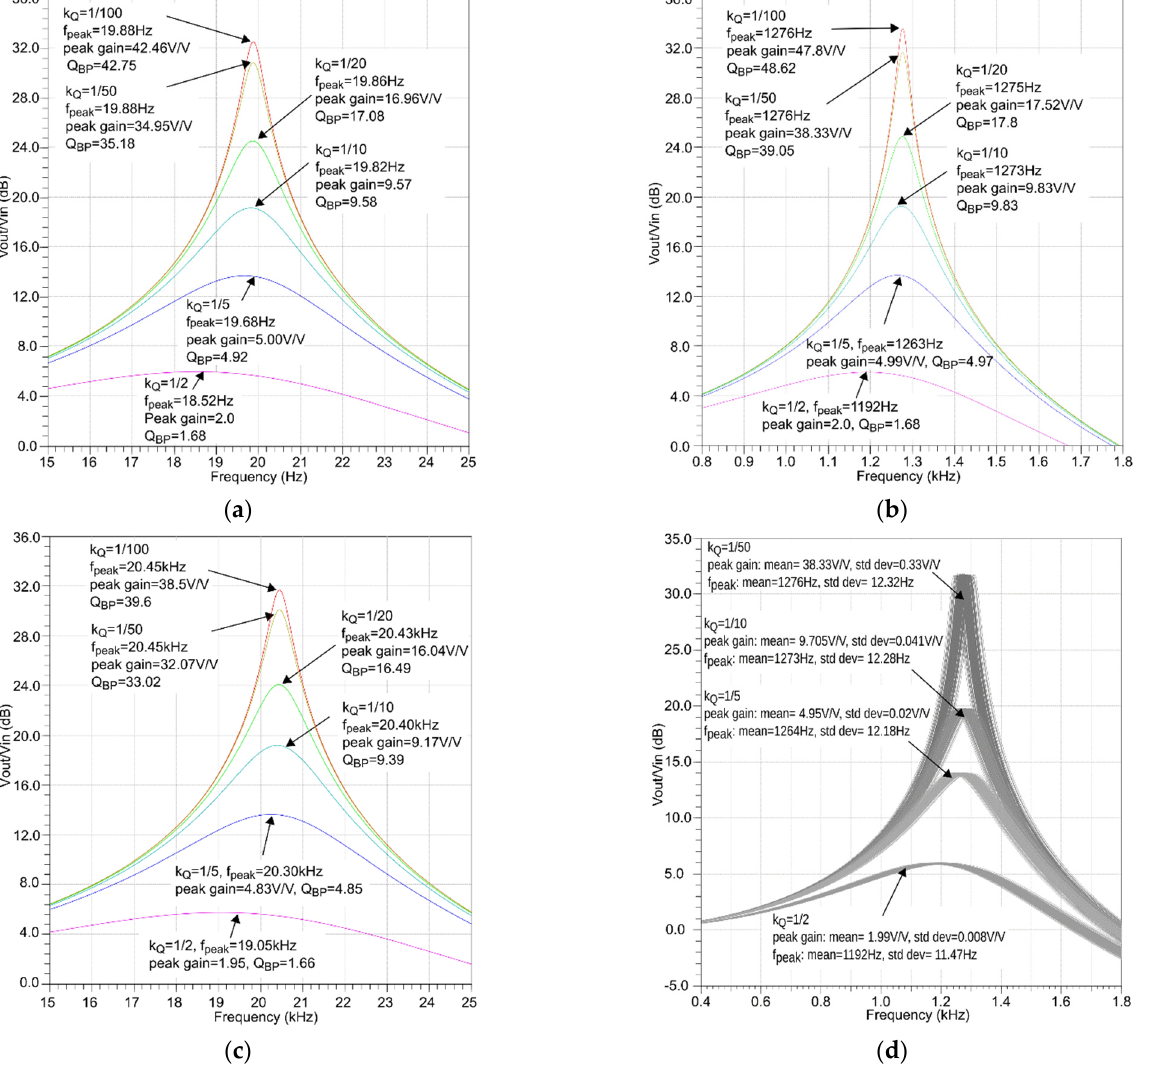
Figure 6. Simulated amplitude responses of the selected filters: ( a – c ) 20 Hz, 1.28 kHz, and 20.48 kHz filters (nominal simulation); ( d ) 1.28 kHz filter under technology mismatch (500 Monte Carlo simulation runs).